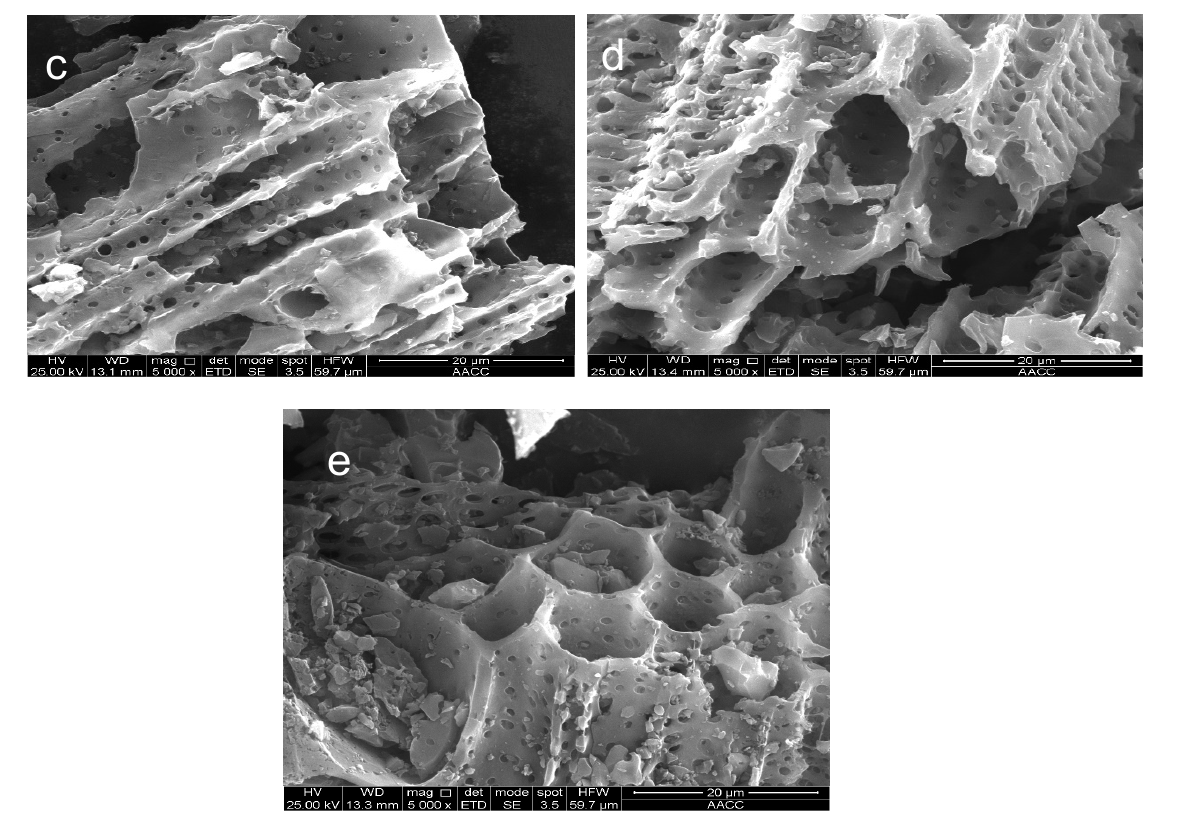
Figure 2. SEM images of ( a ) BC, ( b ) BPC 2.5-900 , ( c ) FBPC 2.5-900-1% , ( d ) FBPC 2.5-900-2% and ( e ) FBPC 2.5-900-4% with ×5000 magnification.